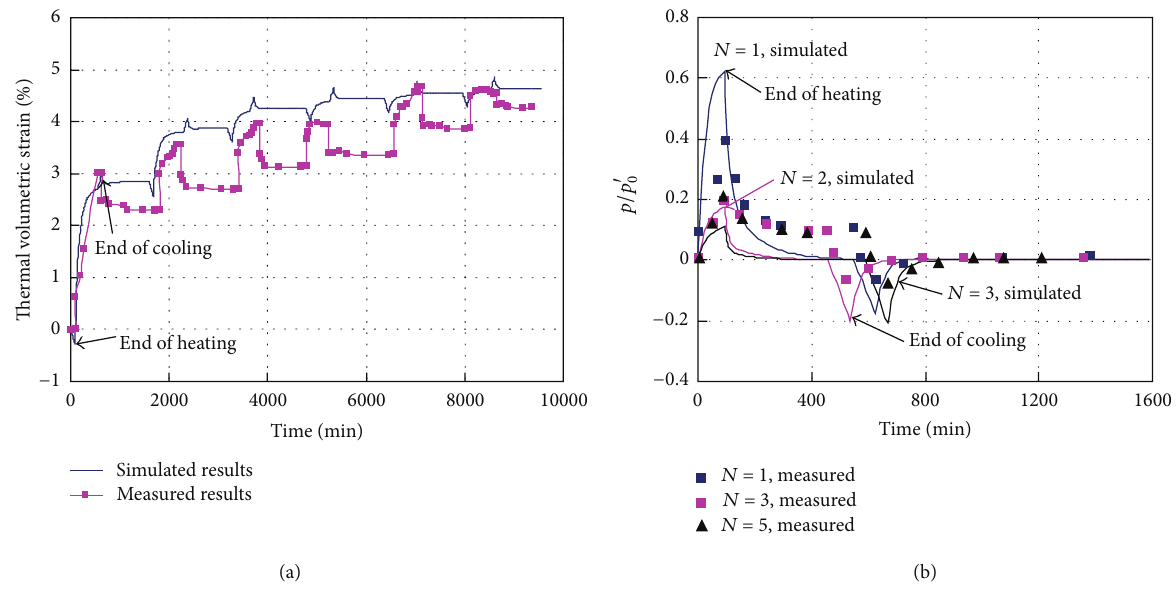
Figure 5: Responses of thermal volumetric strain (a) and pore pressure (b) during the repeated nonisothermal consolidation ( OCR = 1 ; 𝜎 = 100 kPa; N represents the cycle number; measured results are from [11]).